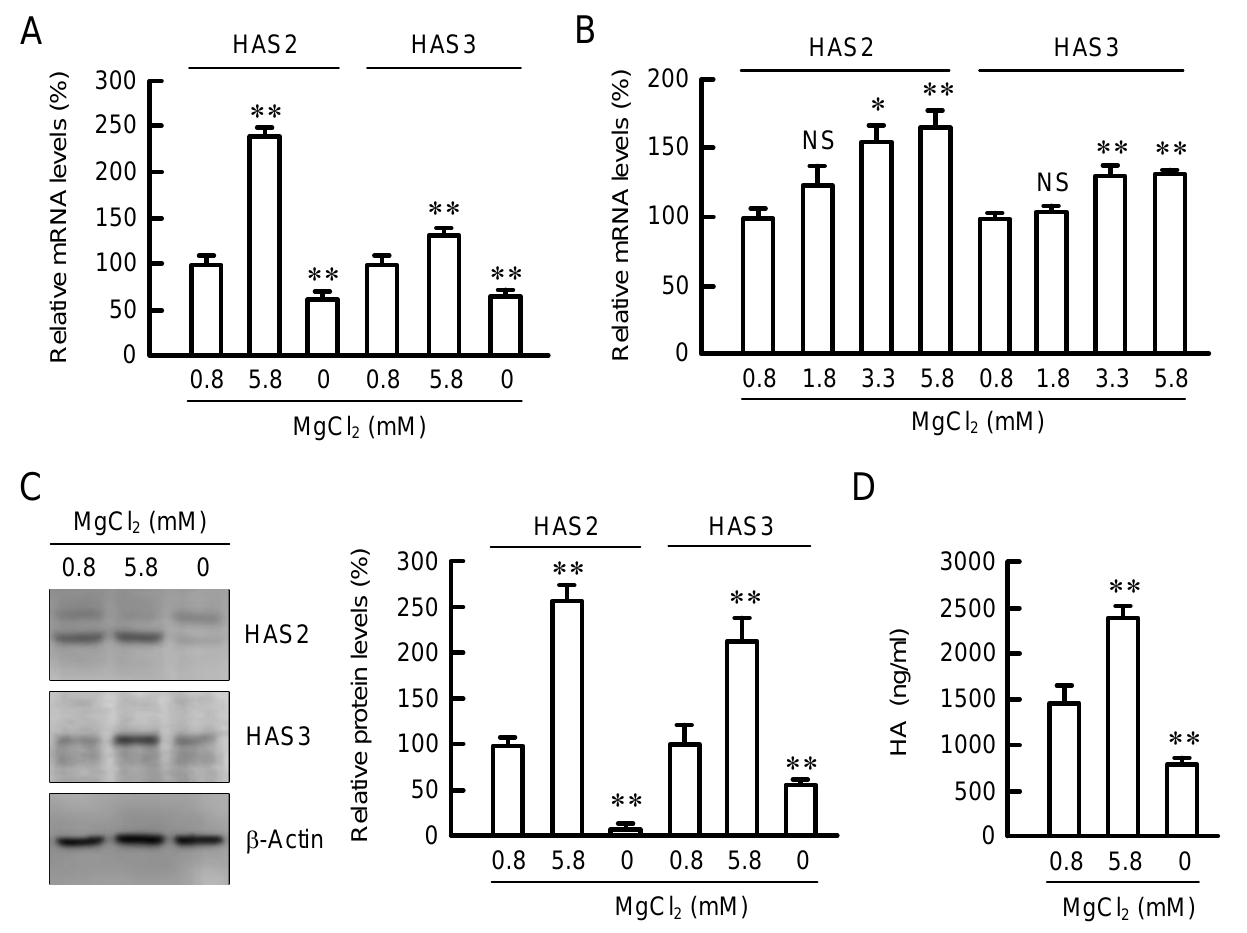
Figure 1. Effects of extracellular Mg 2+ concentration on HAS2/3 expressions in HaCaT cells. ( A , B ) Cells were incubated in the presence of 0, 0.8, and 5.8 mM MgCl 2 for 6 h. The mRNA levels of HAS2/3 were measured by real-time PCR analysis and represented as a percentage of 0.8 mM MgCl 2 . ( C , D ) Cells were incubated in the presence of 0, 0.8, and 5.8 mM MgCl 2 for 24 h. The protein levels of HAS2/3 were measured by Western blotting analysis and represented as a percentage of 0.8 mM MgCl 2 . HA contents in the media were measured using a Hyaluronan Quantification kit. n = 3–4. ** p < 0.01 and * p < 0.05 significantly different from 0.8 mM MgCl 2 . NS p > 0.05.